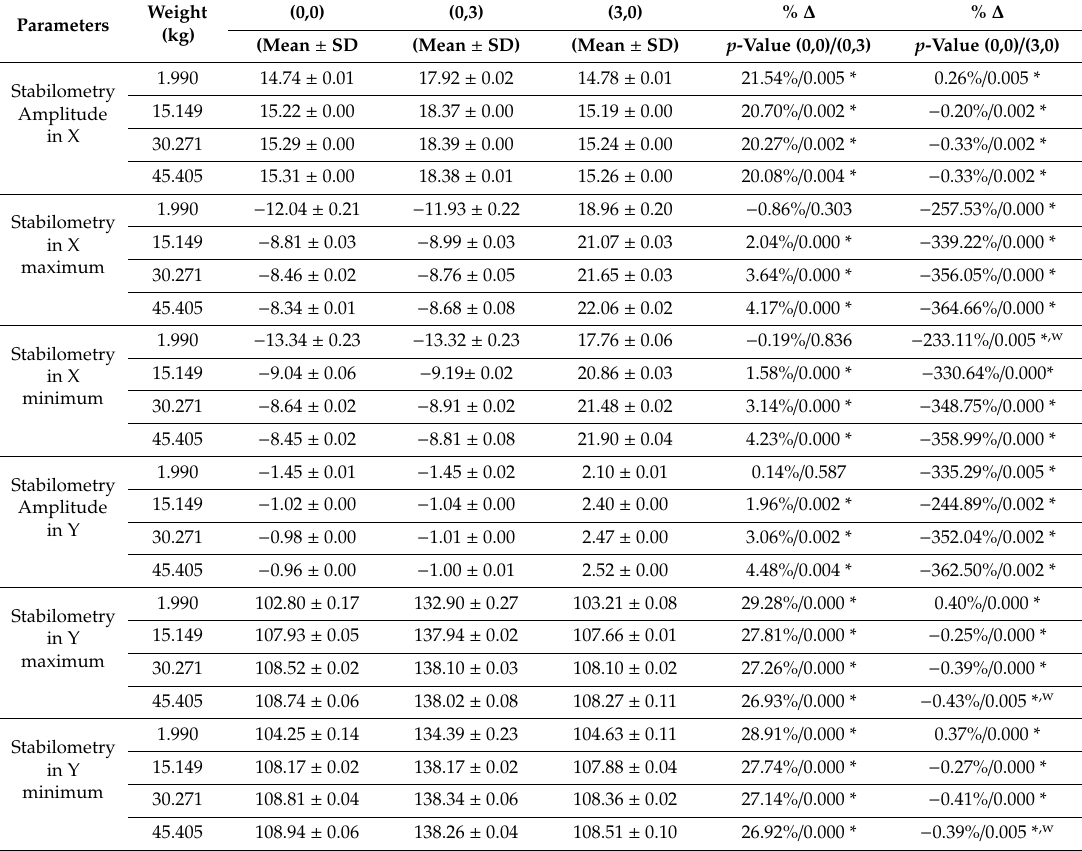
Table 2. Results of force platform Satel validation in amplitude, in the maximum and minimum values on axis x and axis